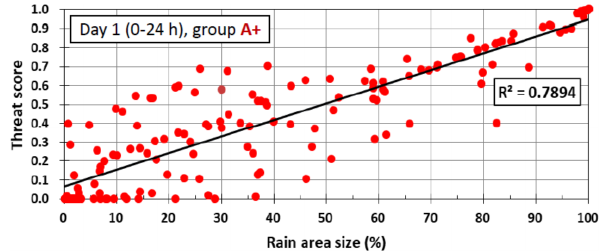
Figure 10. Scatterplot of TS versus observed rain area size (%) from day − 1 QPFs for group A + from 0% to 100% (from high to low rainfall threshold). The squared correlation coefficient ( R 2 ) is